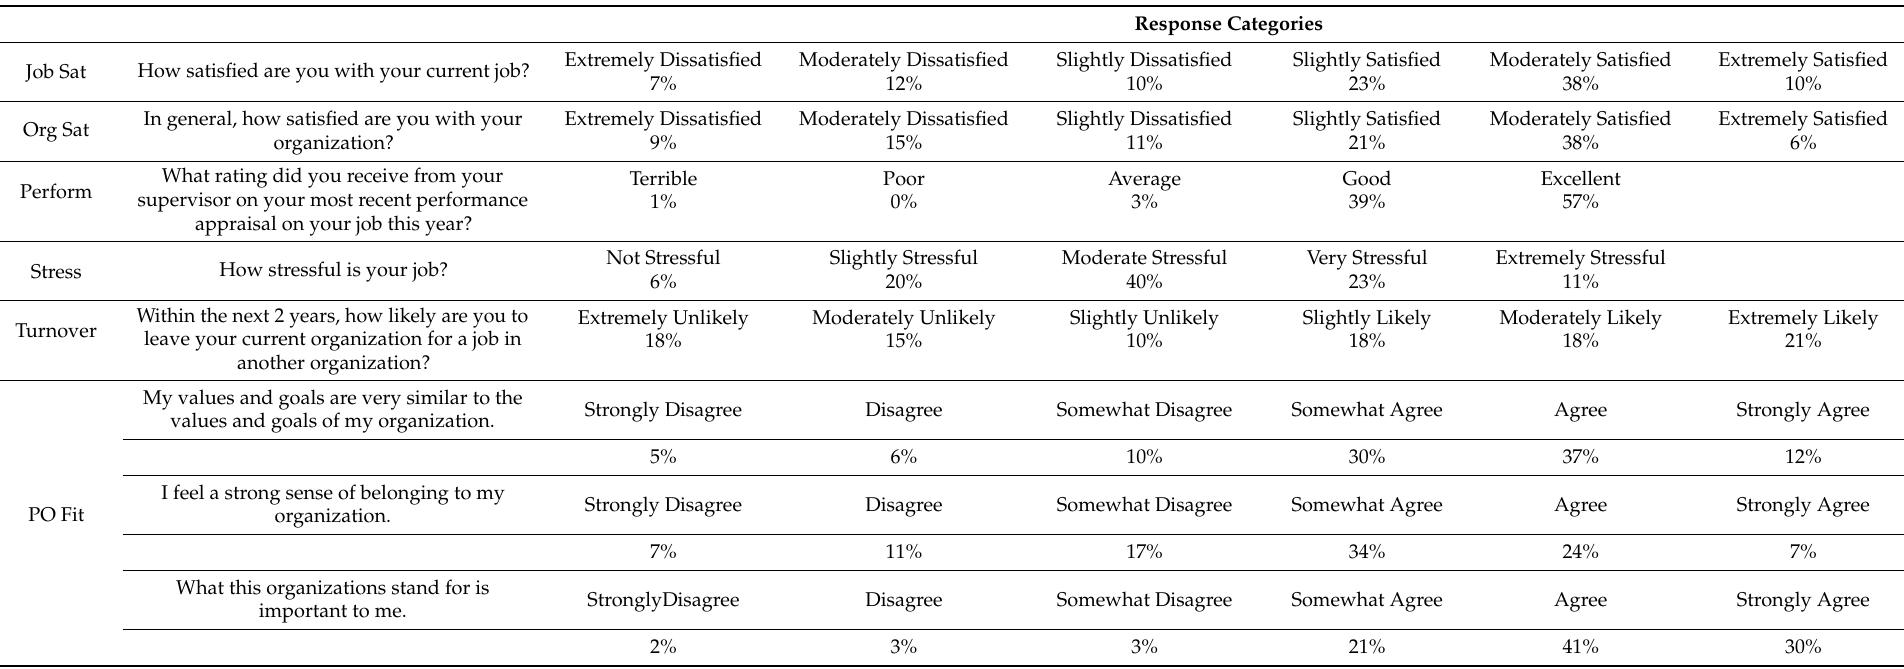
Table 3. Work attitudes and behaviors survey